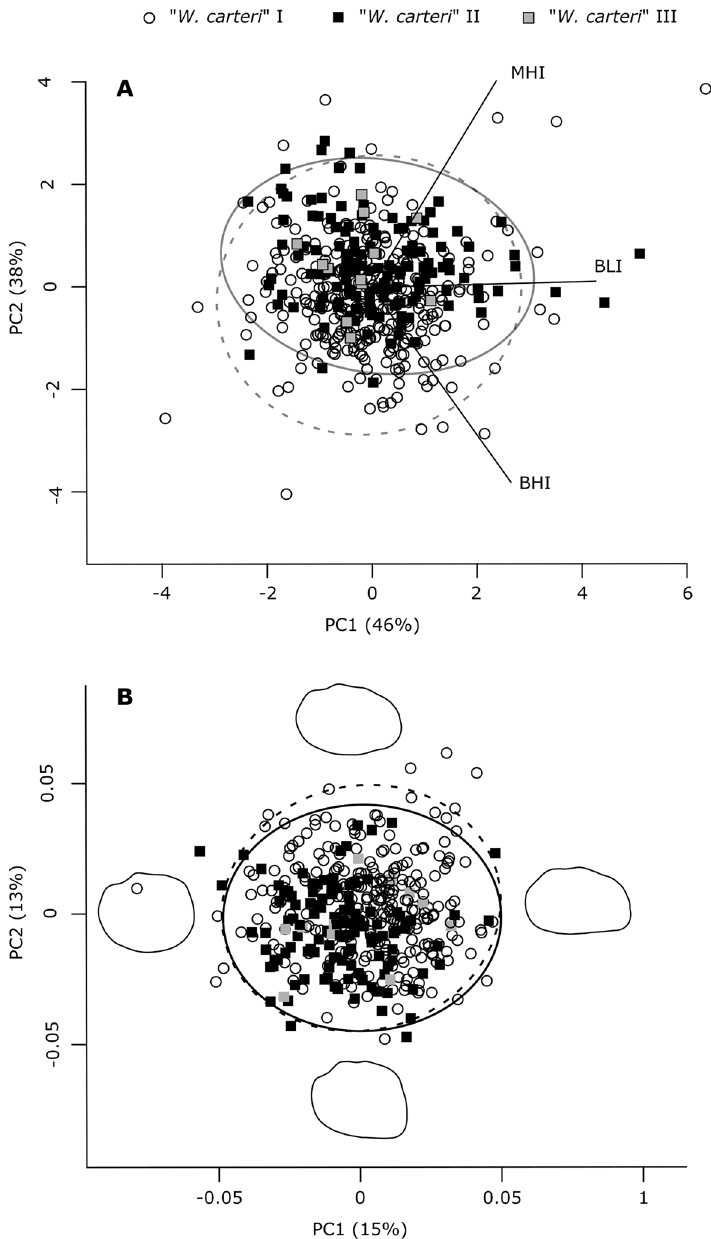
Figure 2. Scatterplots of the first two PC axes obtained by PCA on ( A ) calculated shape indices based on shell measurements, and ( B ) 18 Fourier coefficients for “ Westralunio carteri ” I, “ W. carteri ” II and “ W. carteri ” III. 95% Confidence Intervals are displayed at the species level, i.e., for “ W. carteri ” I (full line) and “ W. carteri ” II + III (dashed line). Extreme shell outlines in ( B ) are depicted to visualise trends in sagittal shell shape, along PC